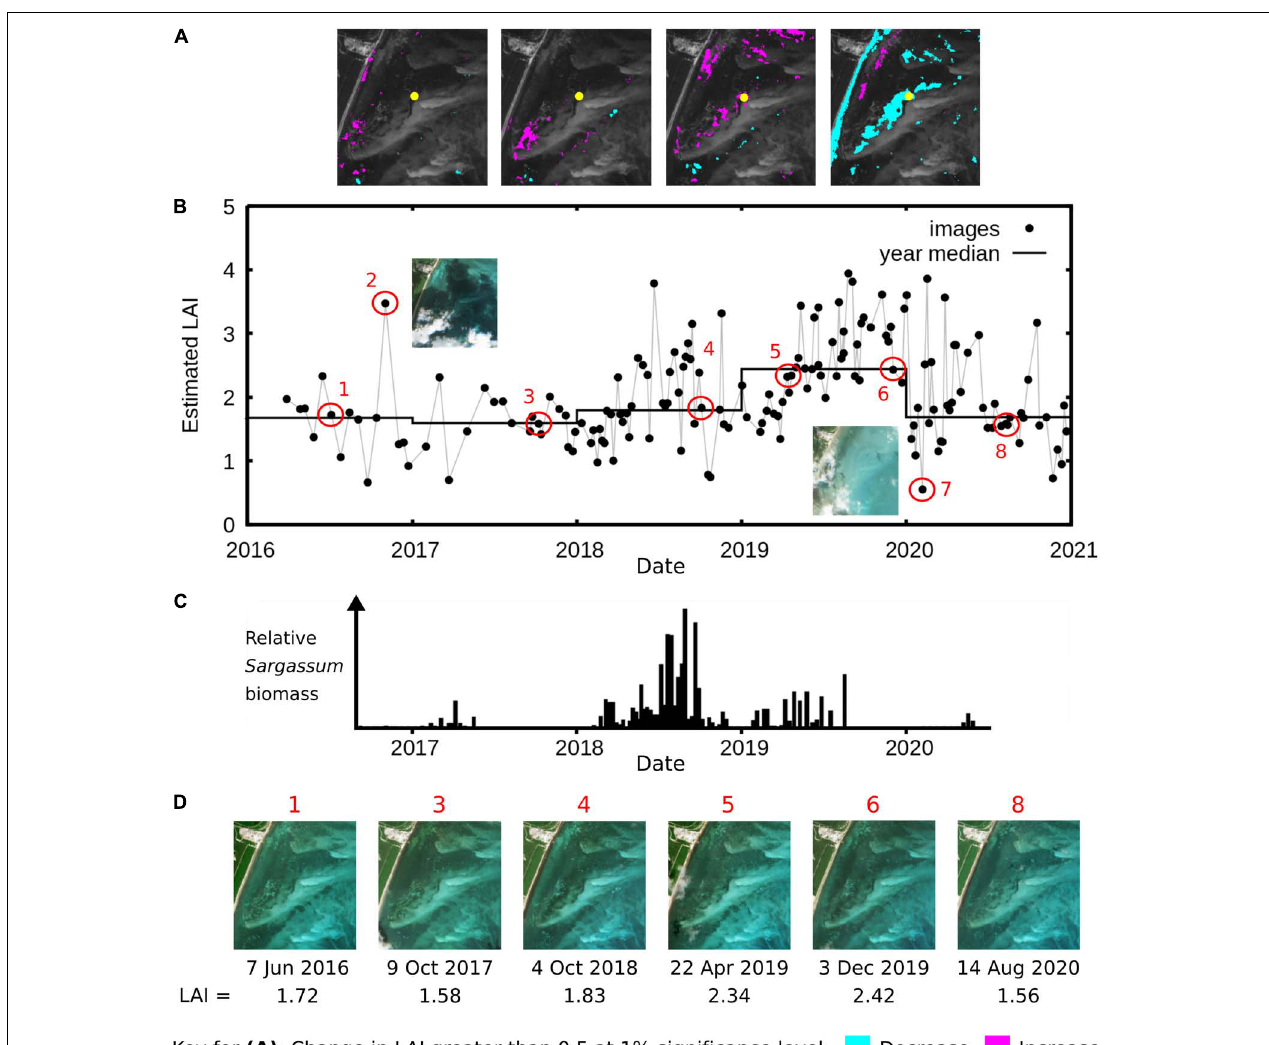
FIGURE 10 | Detail of LAI estimation at one location (21.01747 ◦ N, –86.80708 ◦ W) in the northern Puerto Morelos lagoon. (A) Map of changes of greater than 0.5 LAI ( p < 0.01) in successive year-median LAIs, starting at 2016–2017, etc. (B) Per-image LAI estimate and year median at the yellow point in (A) , note the increase and decrease for 2019 are significant at the 1% level. (C) Sargassum beached biomass data for section of coastline in the area, adapted from García-Sánchez et al. (2020) and aligned with (B) by date. (D) RGB of atmospherically corrected images as highlighted in (B) . Points numbered 2 and 7 in (B) are outliers due to cloud shadow and thin cloud,